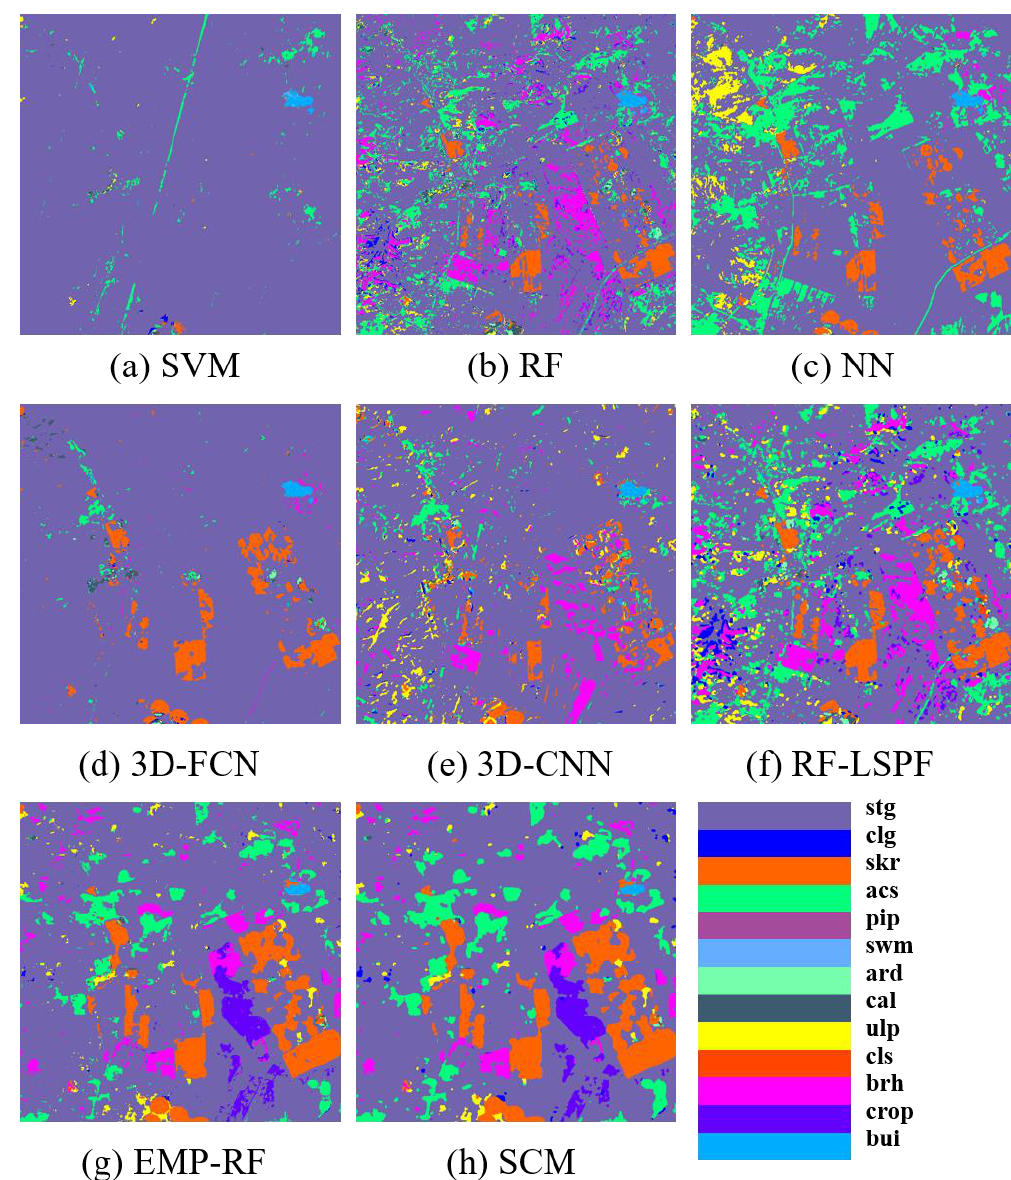
Figure 5. Typical taxonomic region A of grassland communities in Xilinhot. ( a – h ) represent the classification results of SVM, RF, NN, 3D-FCN, 3D-CNN, RF-LSPF, EMP-RF, SCM methods, re- spectively.